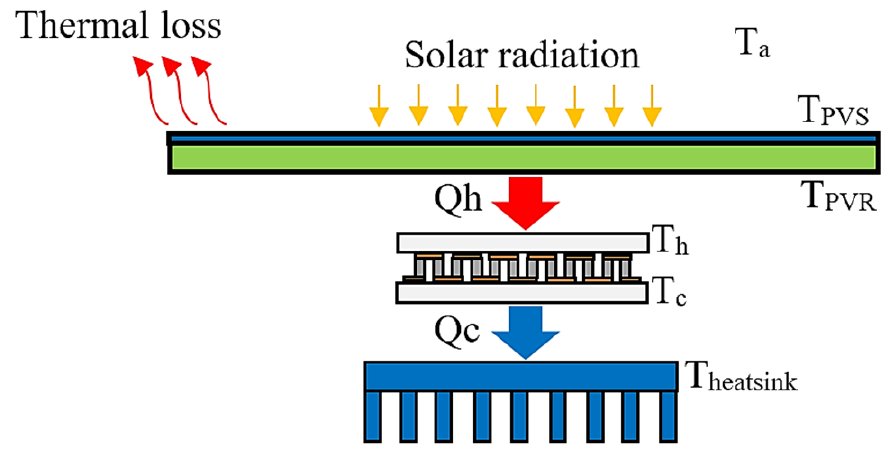
Figure 2. Schematic diagram of the photovoltaic/thermoelectric generator panels [32]. The heat flowing to the hot side of the thermoelectric generator is the sum of contribu- tions from the Seebeck effect, Fourier conduction, and Joule heating without consideration for heat loss, as defined by Equation (1)